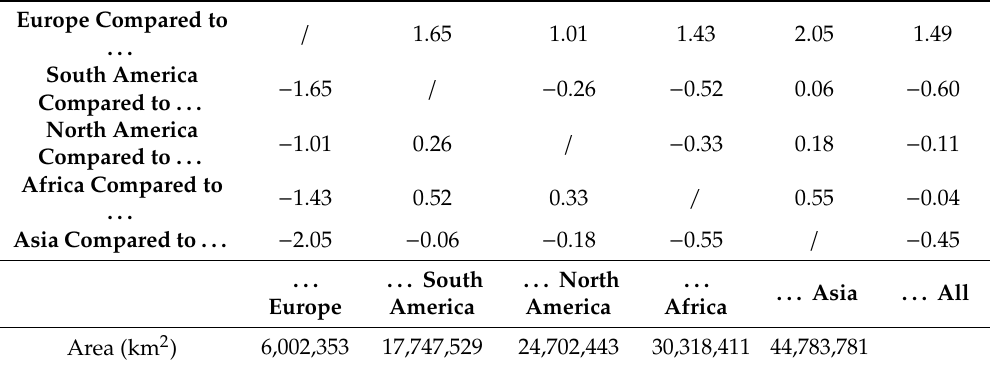
Table 8. Average relative estimated accuracy values for each continent (Mercator projection), in positive values are overestimations, negative values are underestimations. Europe Compared to . . .